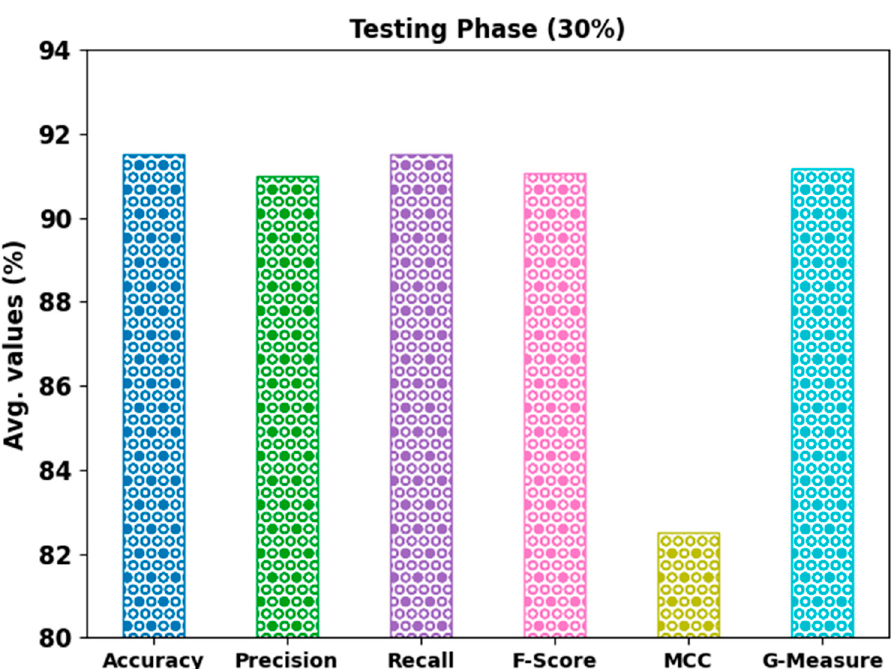
Figure 7. Average analysis of AHBATL-MNC approach under 30% of TS database.